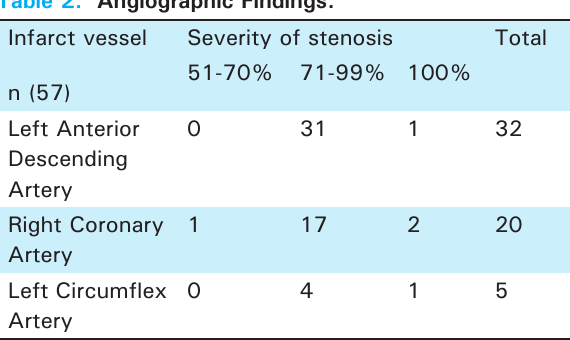
table 2. Angiographic Findings.